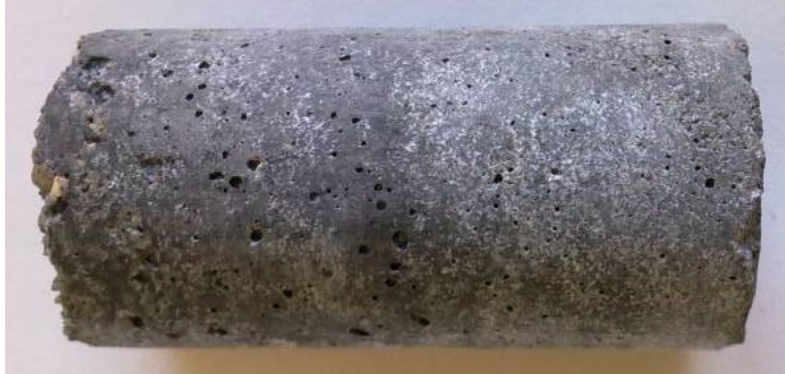
Figure 5: Mortar containing 5 wt% MWCNTs with respect to cement (cylinder is 4 cm in height and has a diameter of 2 cm).